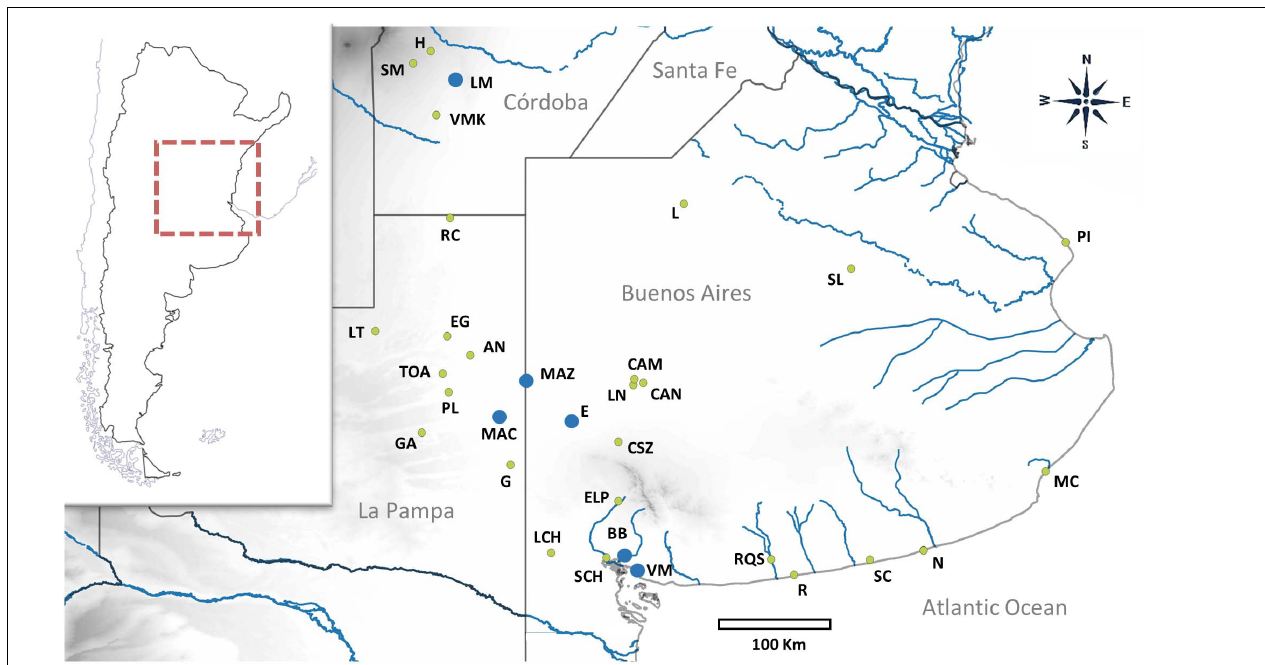
FIGURE 1 | Geographical distribution of sampling locations is indicated with green dots for those previously studied and blue dots for those that are new. Abbreviations of each locality are as follows: H, Holmberg; SM, Sampacho; LM, Estancia Las Marianas; VMK, Vicuña Mackenna; RC, Realicó; L, Lincoln; SL, Saladillo; EG, El Guanaco; AN, Anguil; MAZ, Villa Maza; PL, Reserva Provincial Parque Luro; MAC, Macachín; E, Laguna Epecuén; G, Guatraché; CSZ, Coronel Suarez; ELP, Estancia La Paloma; PI, Punta Indio; MC, Mar de Cobo, RQS, Río Quequén Salado; SCH, Arroyo Sauce Chico; R, Balneario Reta; SC, San Cayetano; N, Necochea; VM, Villa del Mar; BB, Bahía Blanca, LN, La Navidad; CAM, Estancia La Manuela; CAN, Laguna Alsina; LCH, Laguna de Chasicó; LT, Luan Toro; GA, General Acha; TOA, Toay. The corresponding geographic coordinates are shown in Table 1